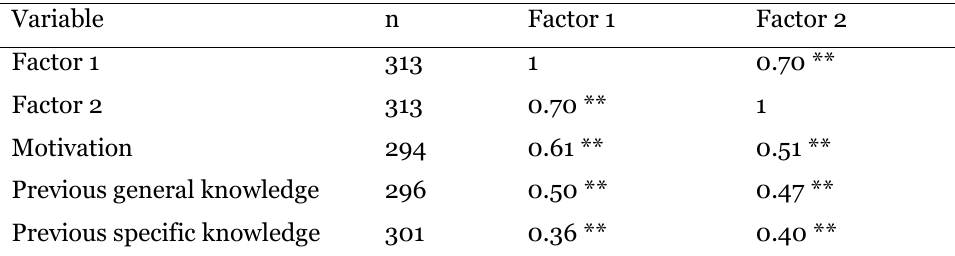
Correlations Between Initial and Final